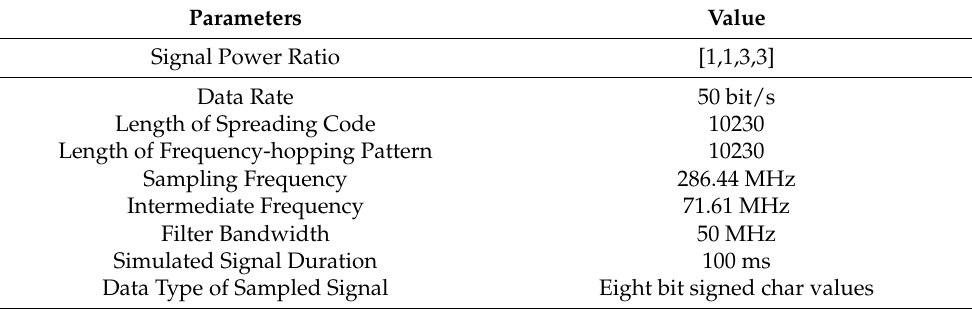
Table 4. Common parameters of the simulated signal.